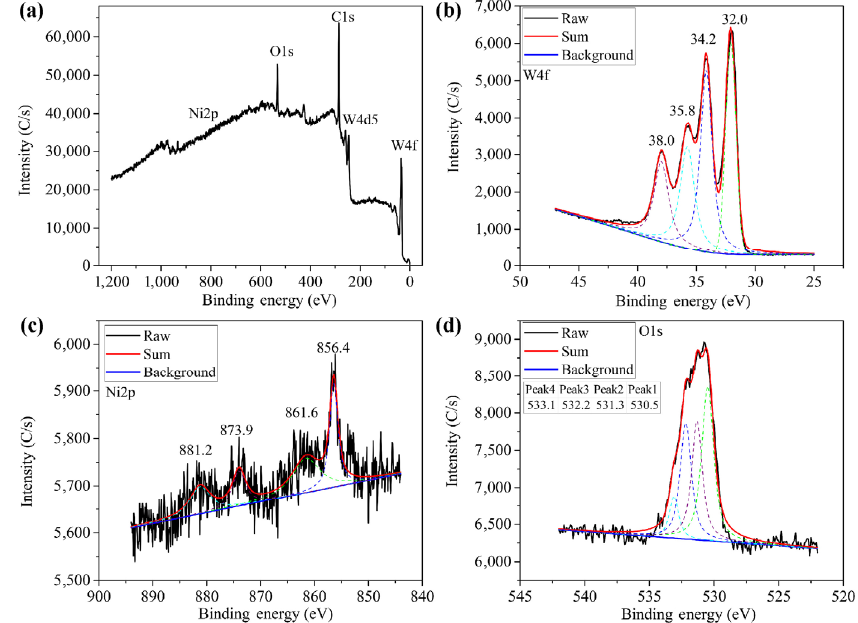
Fig. 11 XPS spectra of irradiated YN6 wear tracks: (a) surface scan; (b) W4f; (c) Ni2p; (d)